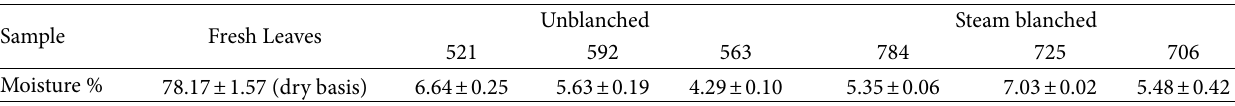
Table 3: Moisture percentages (dry basis).